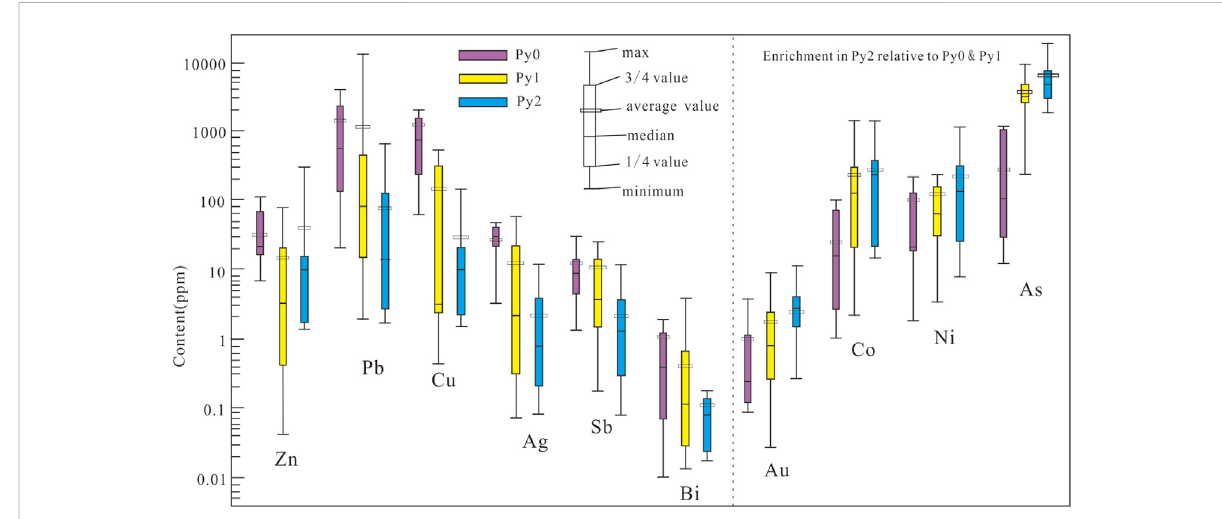
FIGURE 8 Comparative box plot of trace element concentrations in the three pyrite